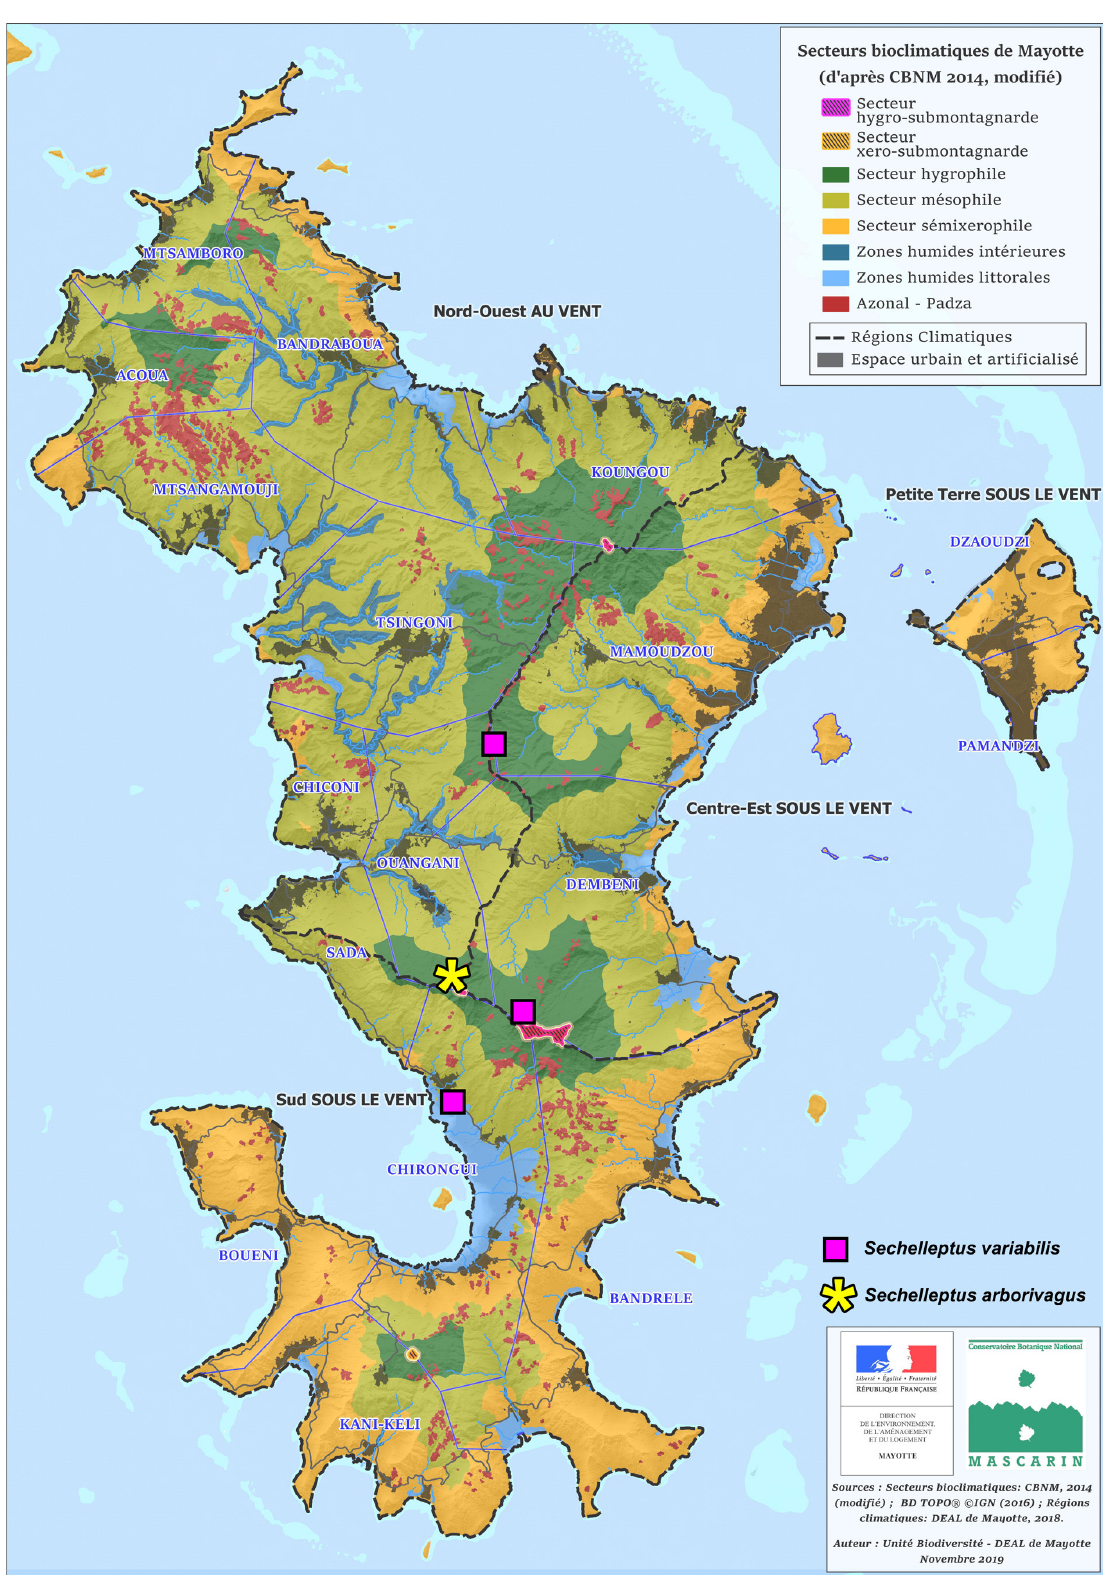
Fig. 8. Distribution of Sechelleptus arborivagus sp. nov and S. variabilis VandenSpiegel & Golovatch, 2007 on